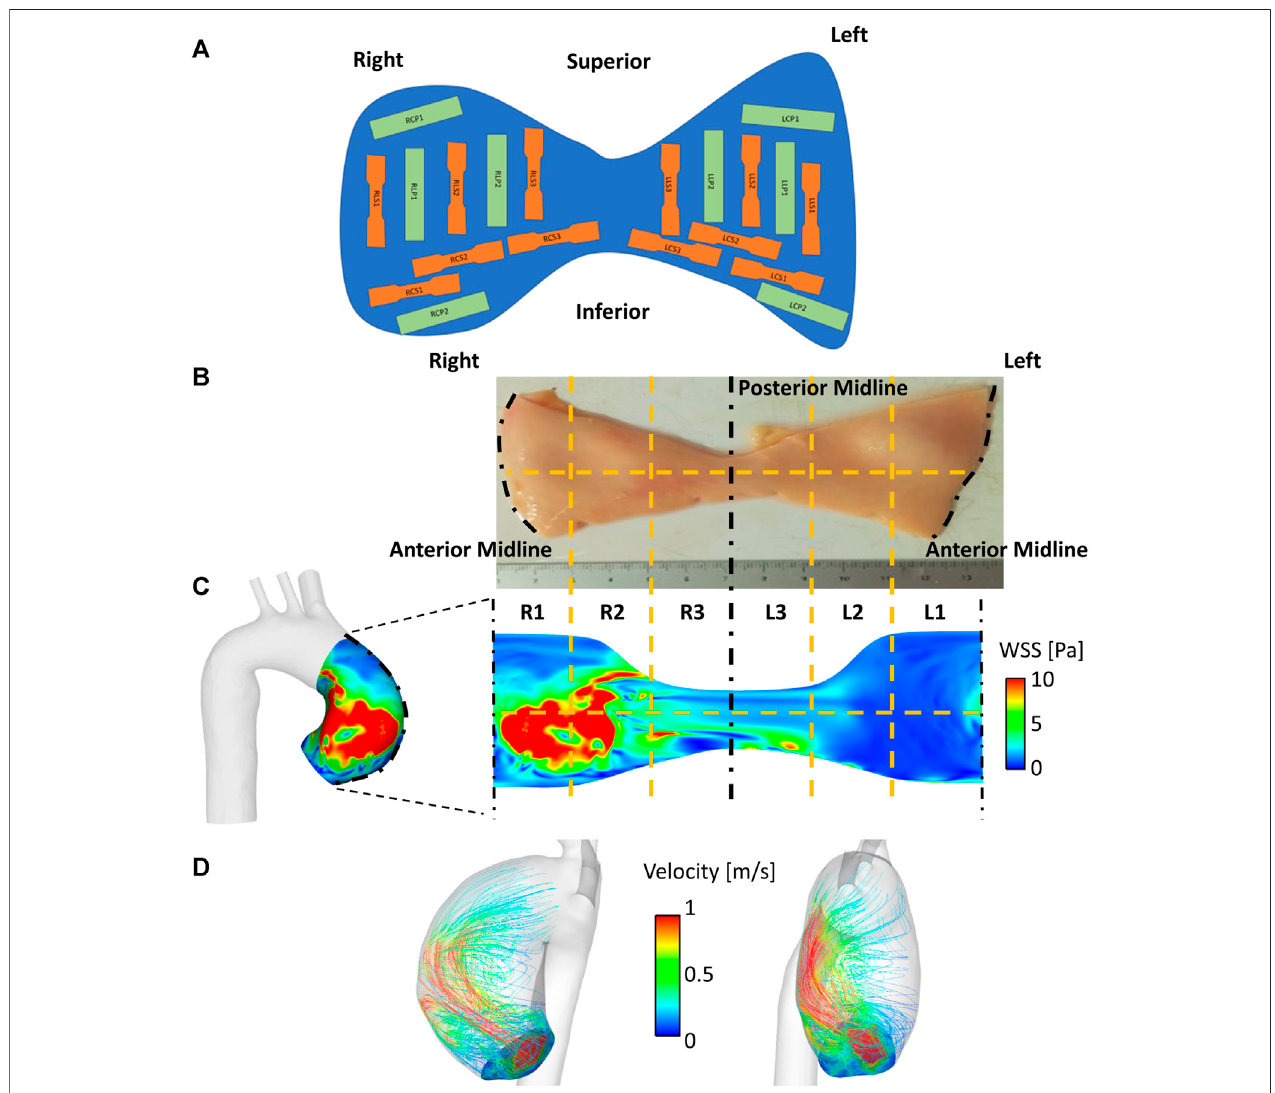
FIGURE1| Matching fl owtomaterialproperties. (A) Referencemapusedforcollection ofsamplesthroughoutthewholeaorticspecimen.Segments areclassi fi ed using alphanumeric codes in which the fi rst letter and number denote the position (R (cid:1) right, L (cid:1) left), the second letter denotes the sample orientation (C (cid:1) circumferential, L (cid:1) longitudinal), the third letter denotes the sample type (S (cid:1) dogbone, P (cid:1) rectangular) (B – C) WSS mapping on to aneurysmal wall surface, whichisunraveledbydivisionalongtheanterior.Thisissubdividedintosixcircumferentialregions(R1-R3,L1-L3),withahorizontaldividingline(12segmentstotal). (D) Streamlines demonstrating haemodynamic fl ow derived from CFD within an anatomically (patient-speci fi c) segmented aortic wall.